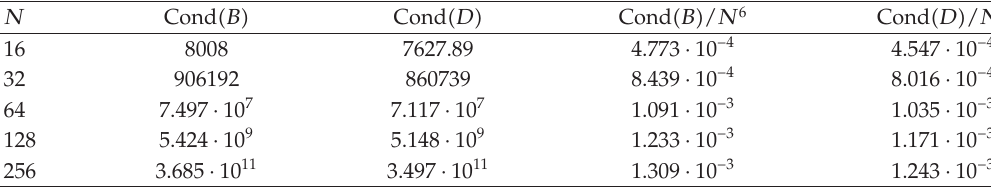
Table 1: Condition numbers for the two matrices B and D